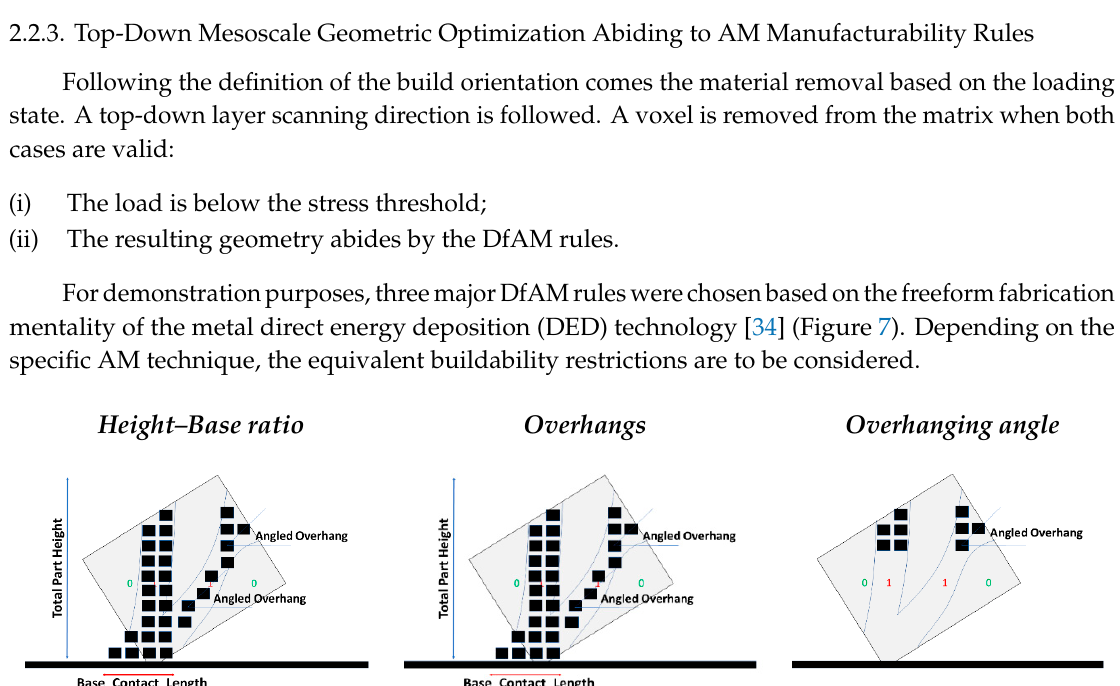
Figure 8. HB ratio illustration.